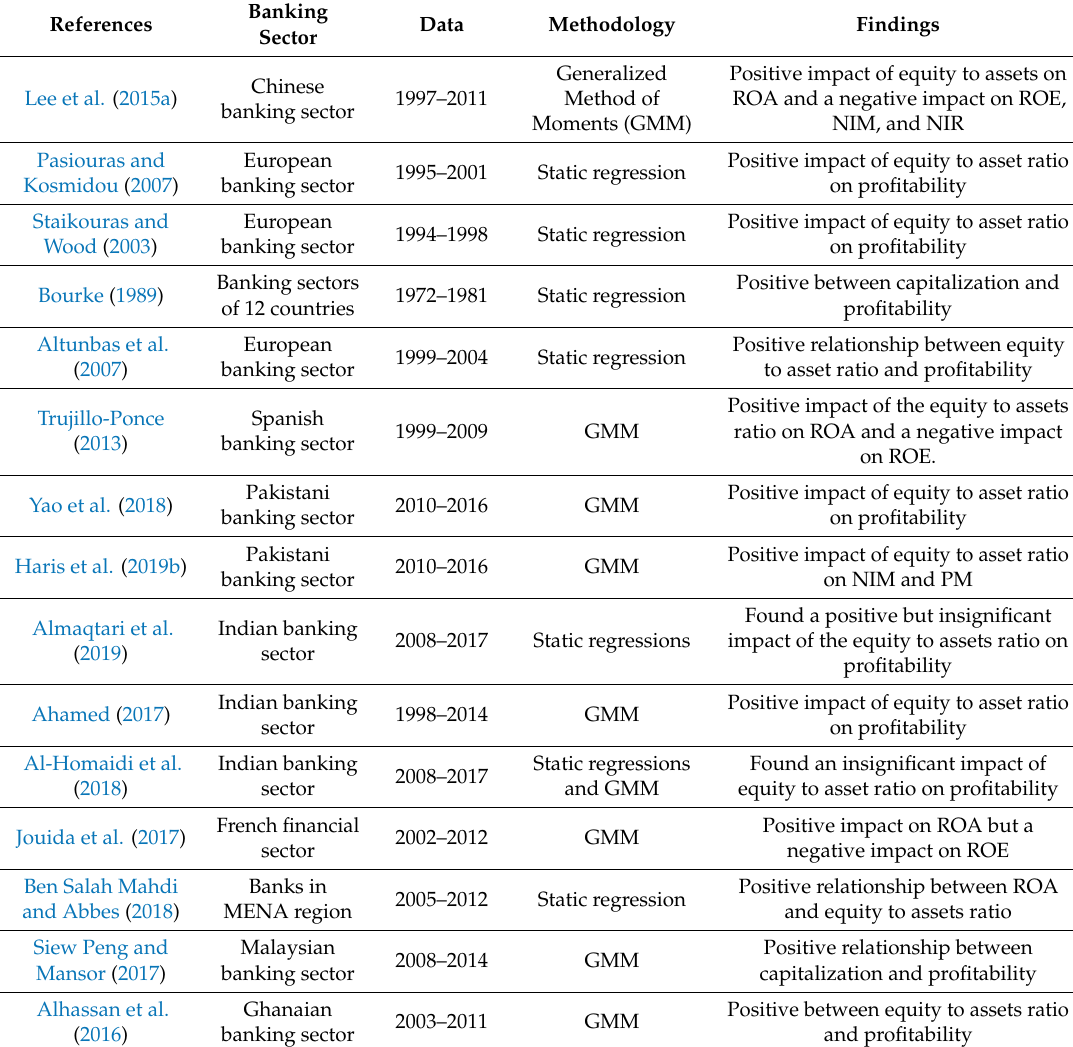
Table 1. Summary of the literature review on the relationship between capitalization and bank profitability in di ff erent